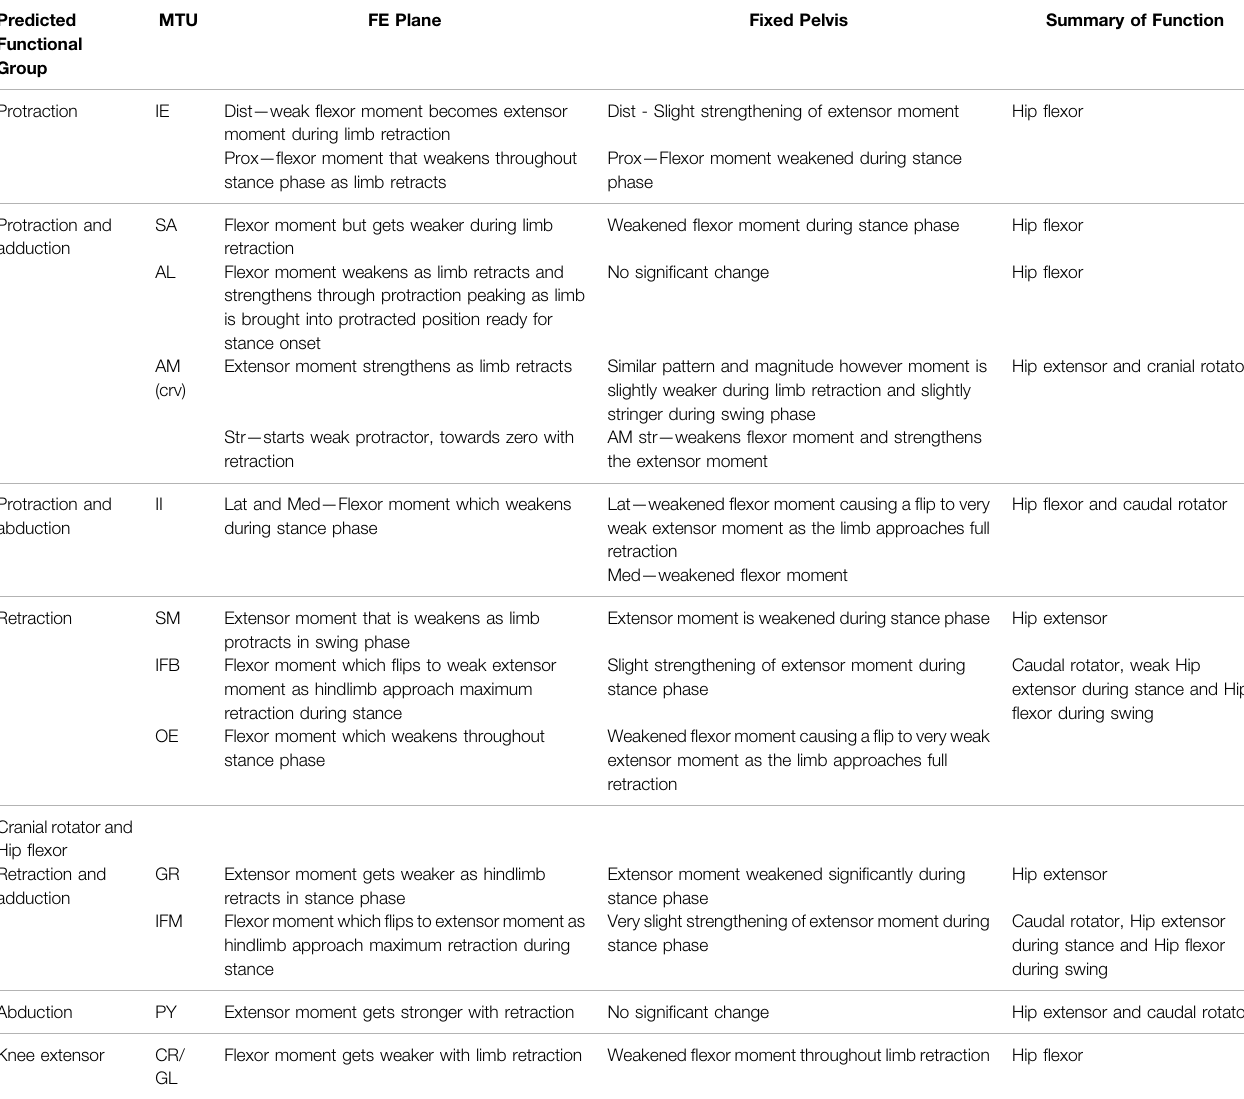
TABLE 6| Results ofwalkingsequence simulations RUN_ROT andRUN_FIXdescribing theimpactof fi xingpelviclateral rotationonthe fl exion/extension(FE)moment arms of the hindlimb muscles. Predicted